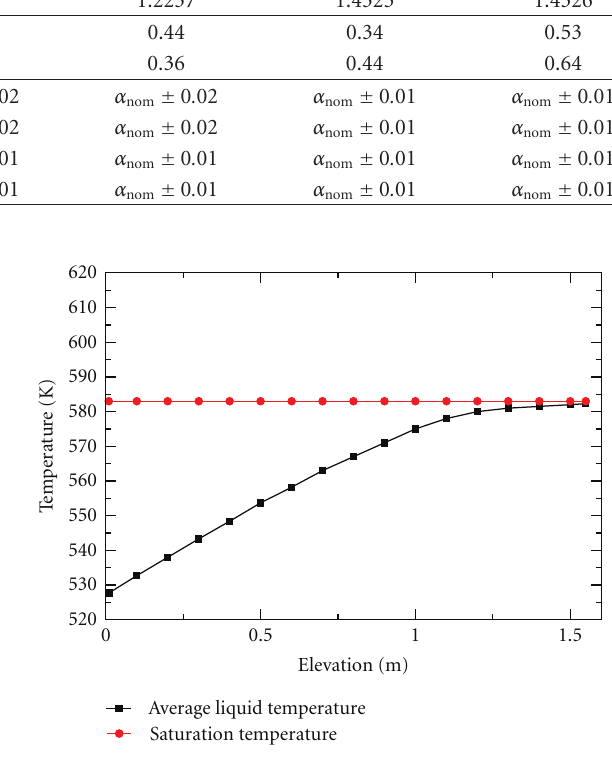
Figure 10: Run 1.4325: Longitudinal evolution of the average liquid temperature and of the saturation